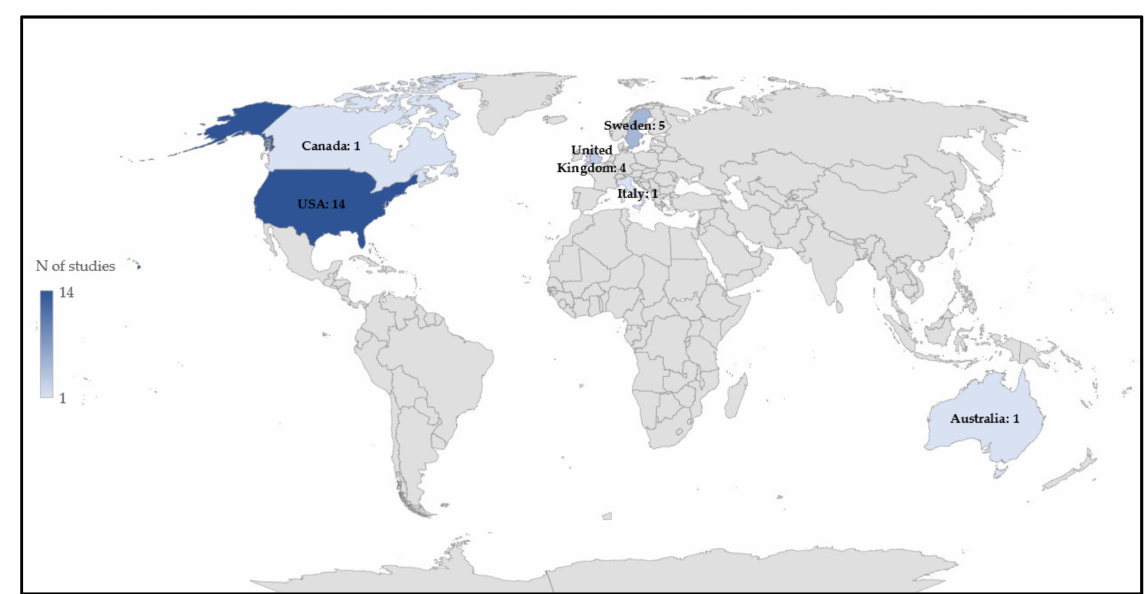
Figure 3. Number of eligible papers published per country ( n